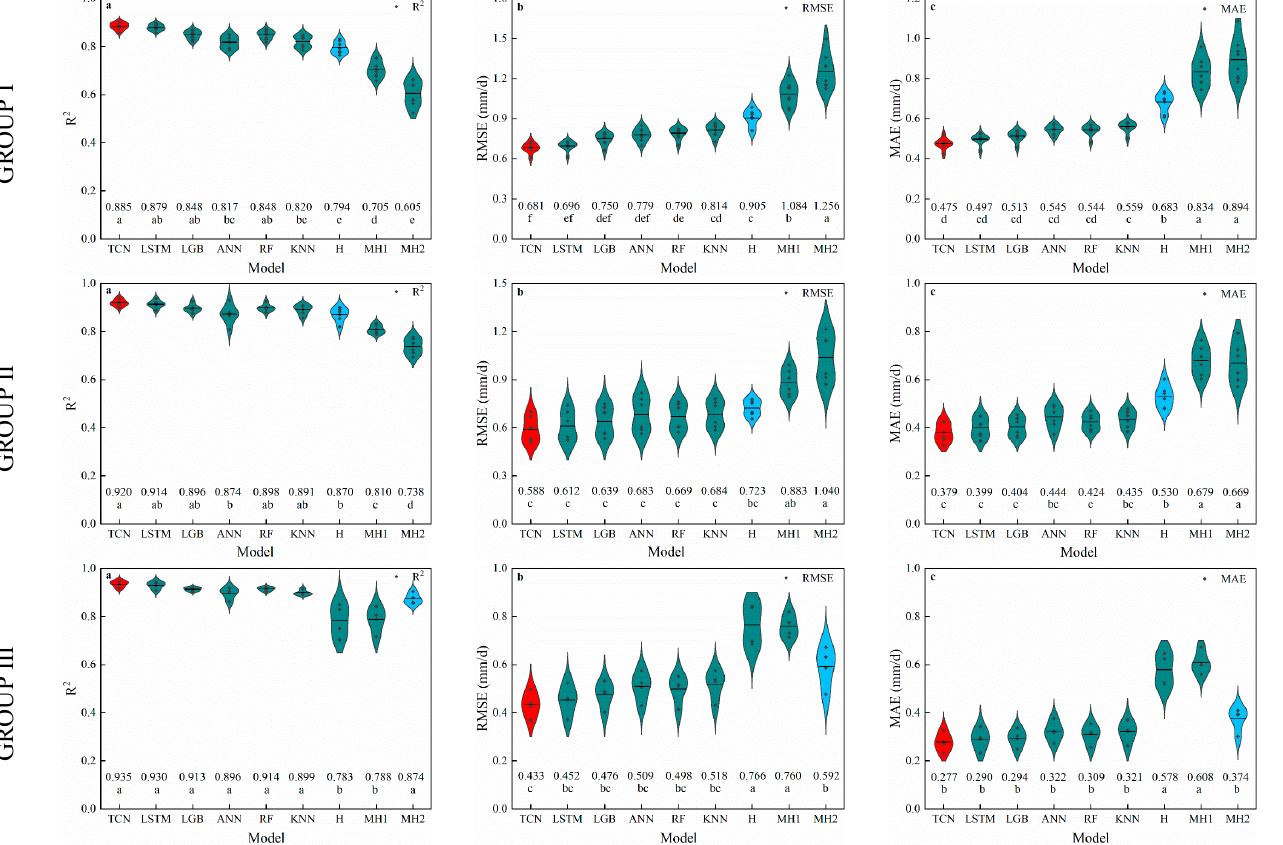
Figure 3. The performance of the temperature-based models during the first strategy: ( a ) determination coefficient (R 2 ), ( b ) root mean square error (RMSE), and ( c ) mean absolute error (MAE). Note: Values on the same line with different lowercase letters are significantly different at the 5% probability level. The same is shown below.